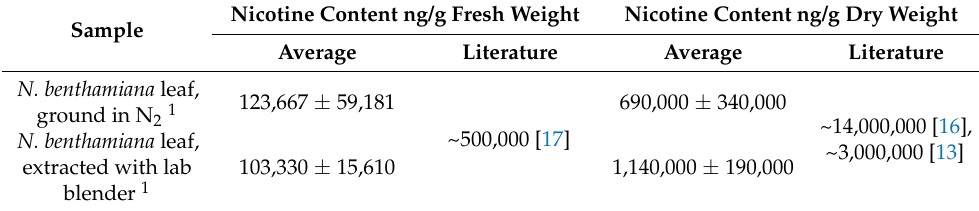
Table 3. Nicotine content of non-treated N. benthamiana. Total soluble protein (TSP) extracts analyzed for alkaloid content by high-performance liquid chromatography—tandem mass spectrometry (HPLC-MS/MS) were prepared with two different extraction methods and the nicotine contents determined were compared to